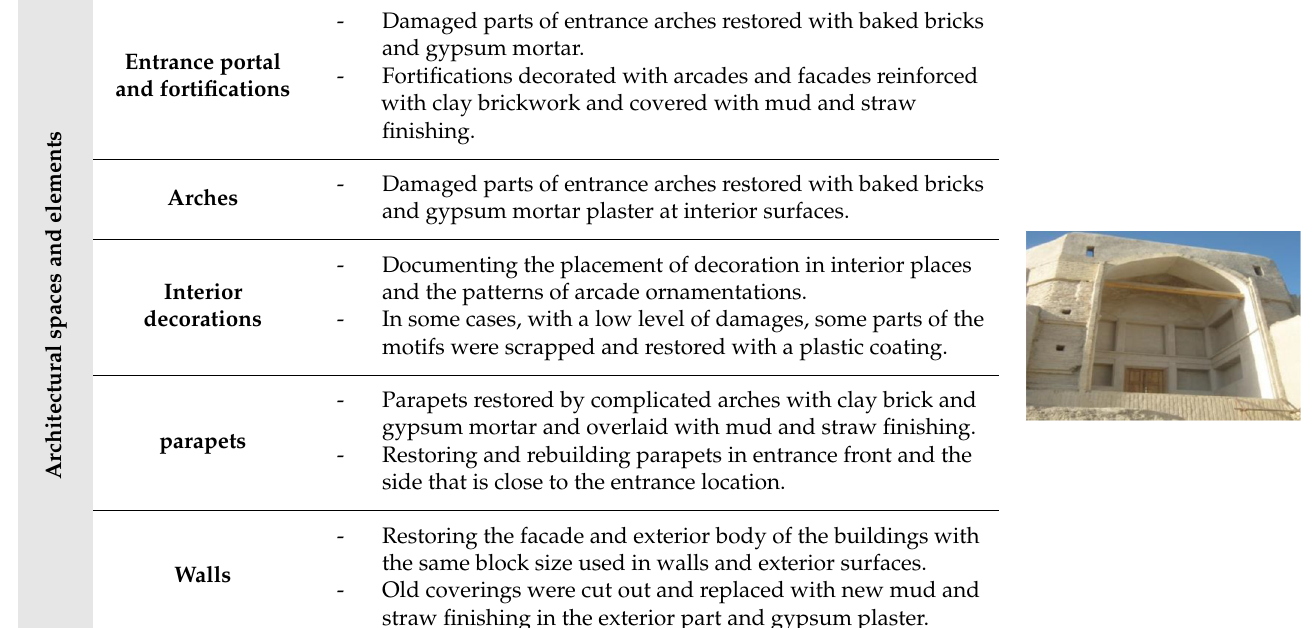
Table 6. Conservation plan for physical spaces (Sekouheh Castle).